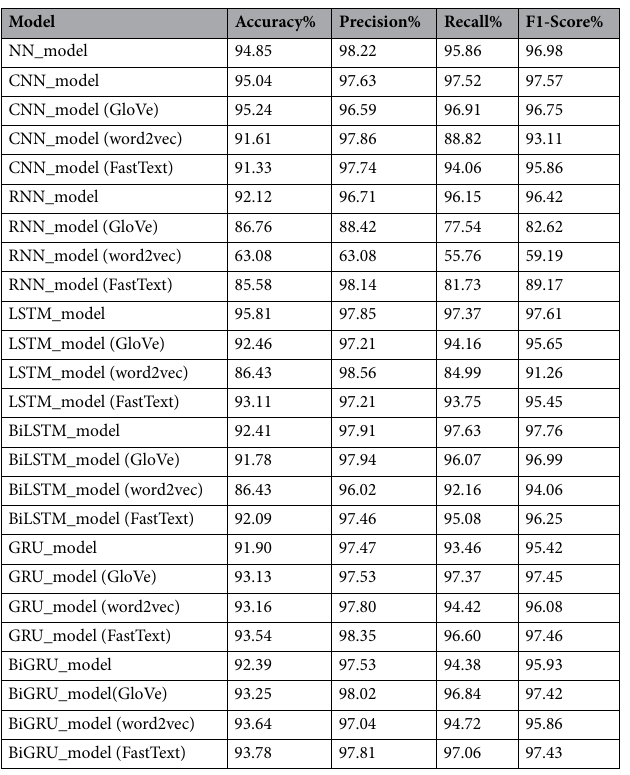
Table 4. Comparison of DL classifiers with word embeddings using religious toxic comments dataset.